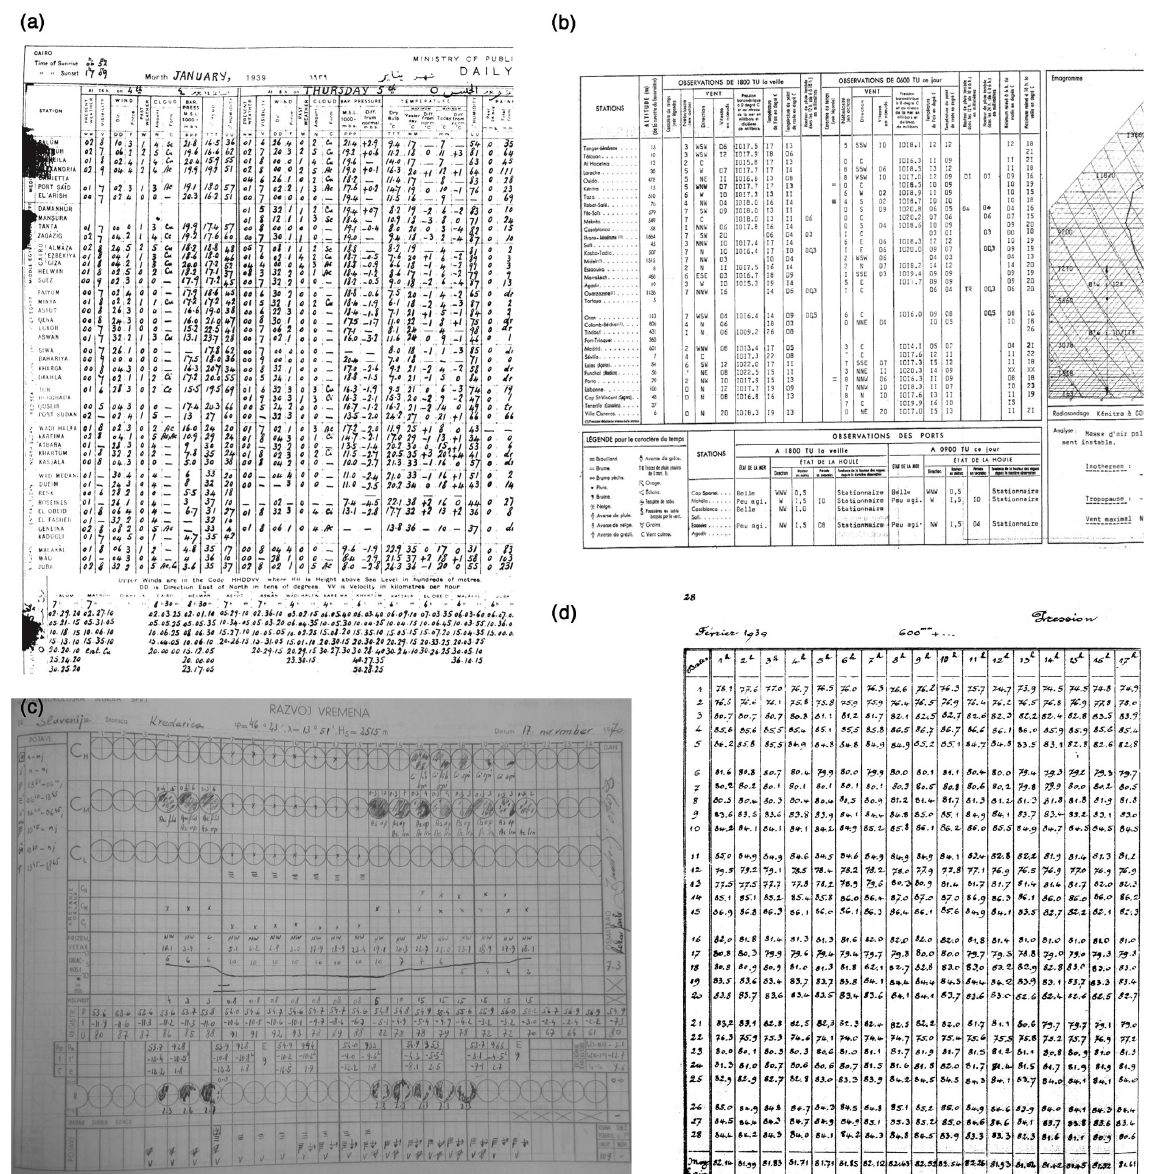
Figure 2. Examples of the different data source formats found for digitisation: (a) Egypt, 1939, where each row is observations from a different station on 1 day; (b) Morocco, 1968, where each row is observations from a different station on 1 day; (c) Kredarica, Slovenia, 1970, where each row is observations of a different variable for one station on 1 day; (d) Ksara, Lebanon, 1939, where each row is atmospheric pressure data for 1 day at one station. Data images are available online the Universitat Rovira i Virgili’s Centre for Climate Change (see Sect.